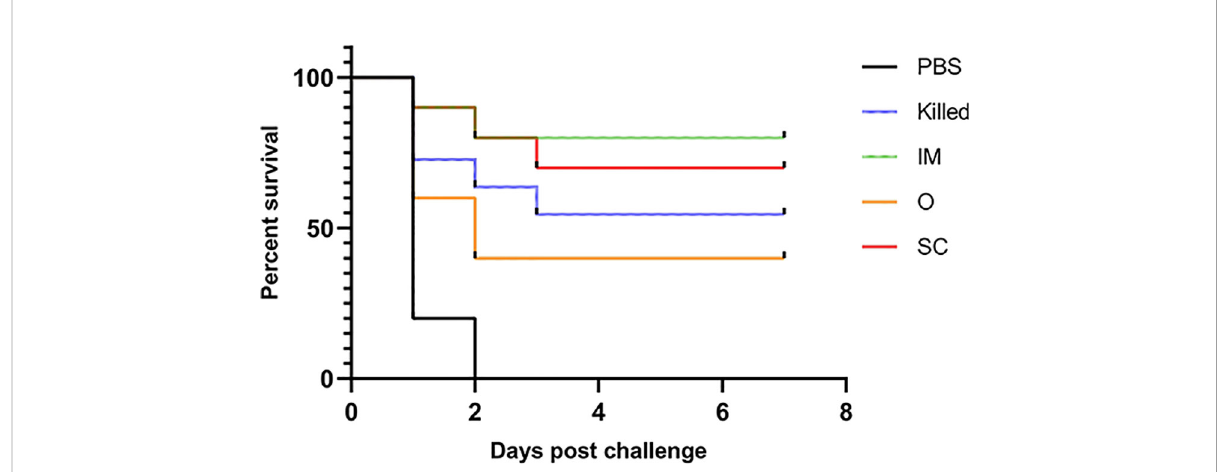
FIGURE 5 Survival rates of vaccinated mice after challenge with 5 LD 50 CE9 strain. Except for the PBS group, all experimental groups protected some mice from the CE9 strain-induced